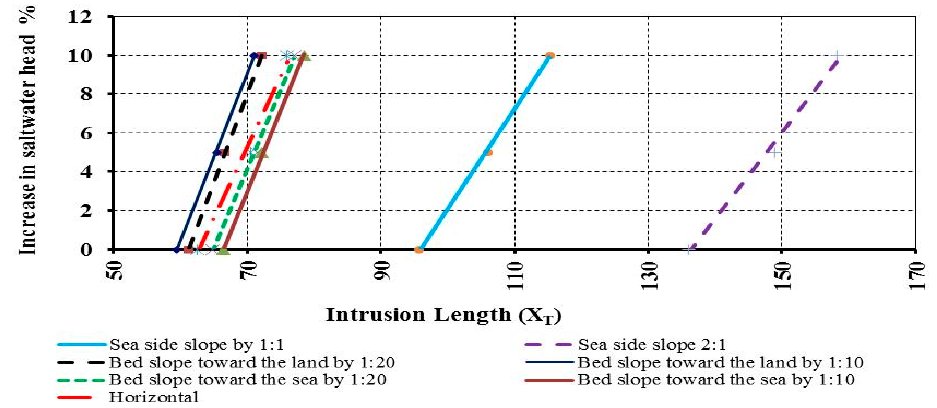
Figure 12. SWI due to increasing saltwater head by ( a ) 5% and ( b ) 10%.